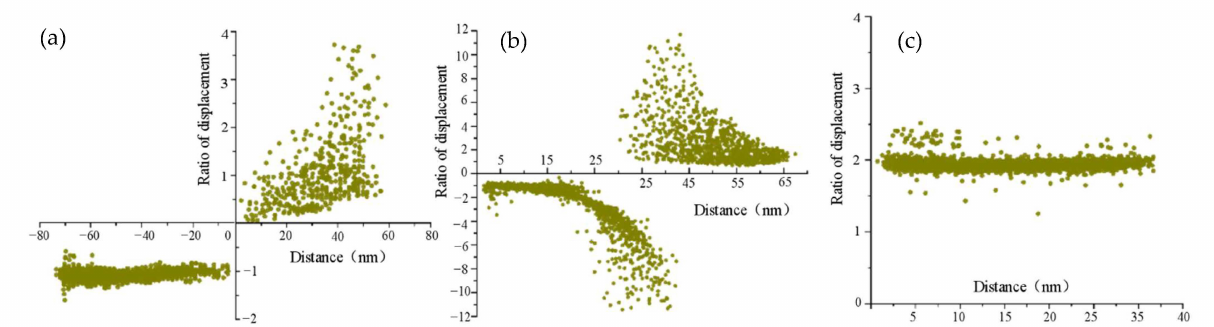
Figure 3. Atomic displacement scatter plot for different chip states. ( a ) Both sides of the tip; ( b ) The spherical chips; ( c ) The strip chips.